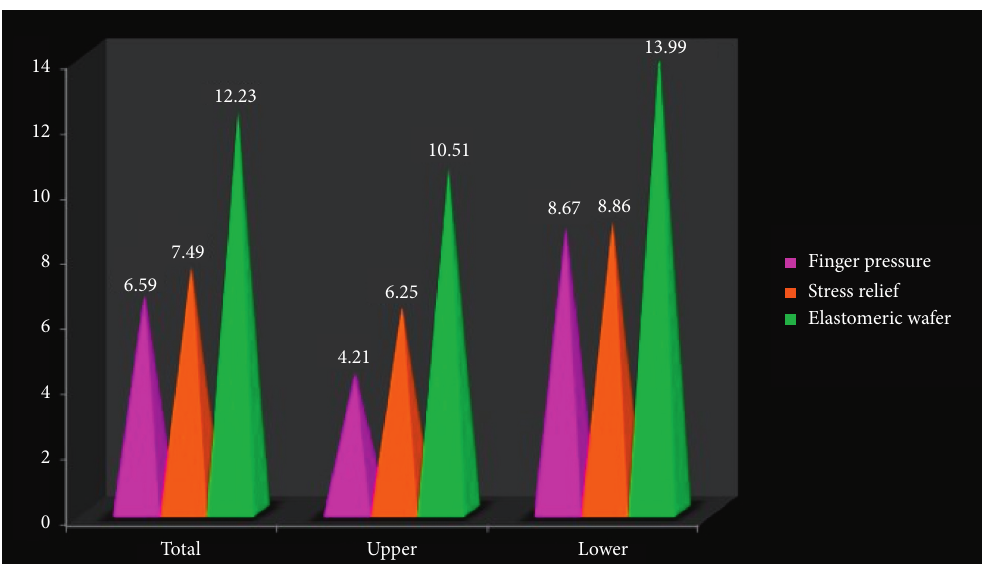
Figure 4: Median score for